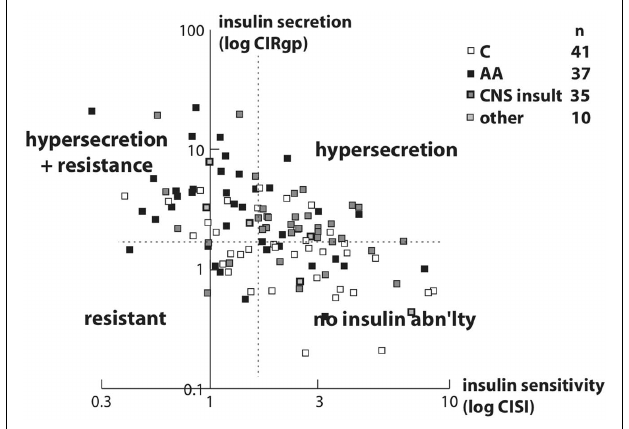
FIGURE 3 | Scatterplot of insulin secretion (Corrected Insulin Response, or CIRgp) vs. sensitivity (Composite Insulin Sensitivity Index, or CISI) plotted logarithmically in 113 obese non-diabetic children. A negative linear correlation was noted ( r =− 0.54, p < 0.001). Different racial and etiopathogenic groups tended to plot in different areas. Arbitrary cutoffs (dashed lines) for CIRgp (1.5) and CISI (1.7) divide the plot into four quadrants.The majority of Caucasian children (open squares) plotted in the lower right quadrant, with a CIRgp less than 1.5 and a CISI greater than 1.7, indicating lower insulin secretion and better insulin sensitivity.The preponderance of children with hypothalamic obesity (gray squares) plotted in the upper right quadrant, with a CIRgp of greater than 1.5, and with a CISI of greater than 1.7, indicating insulin hypersecretion with better insulin sensitivity. Finally the majority of African American children (filled squares) plotted in the upper left quadrant, with a CIRgp of greater than 1.5 and a CISI of less than 1.7, indicating both insulin hypersecretion and resistance (Preeyasombat et al., 2005). From Elsevier, with